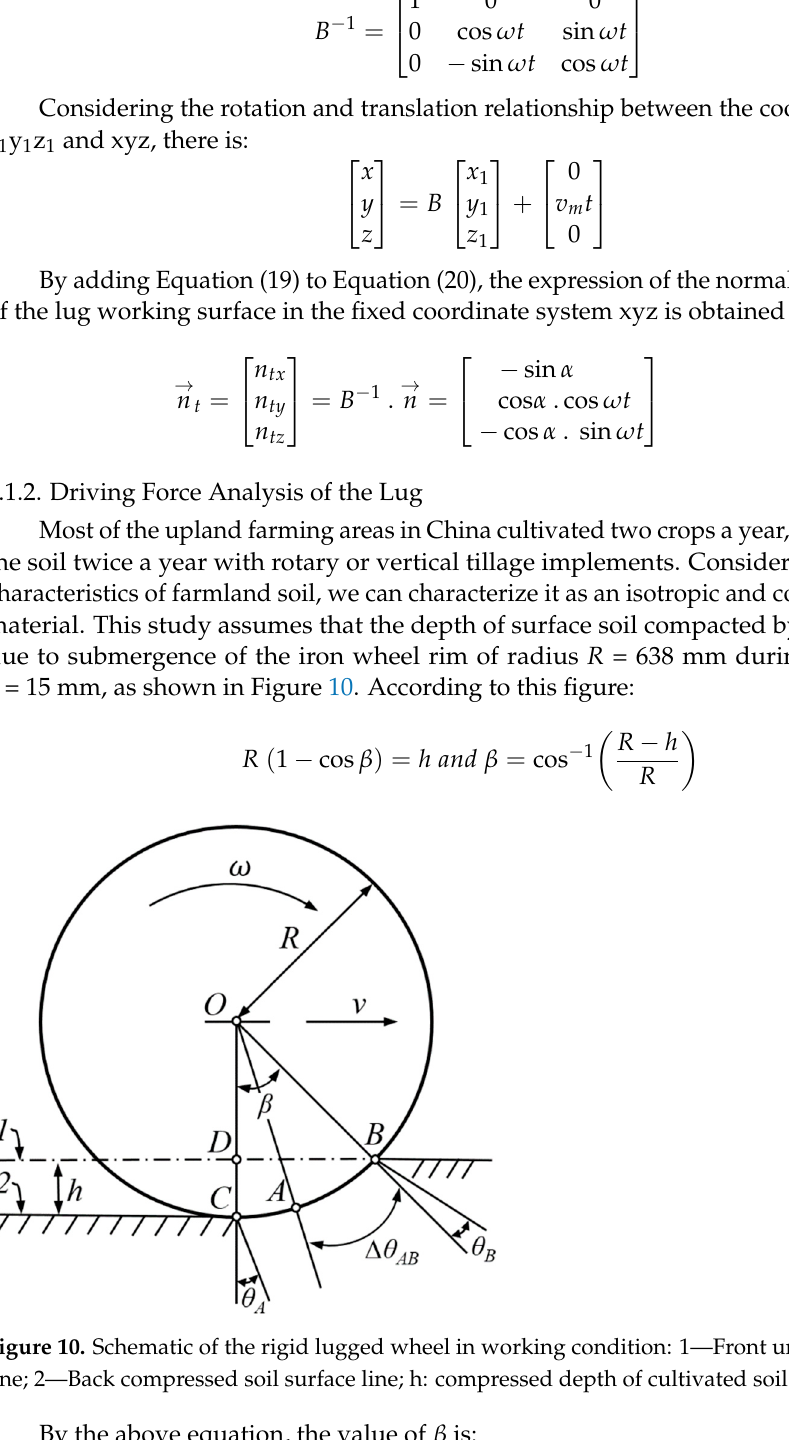
β = 12.4488 ◦ = 0.217273 rad